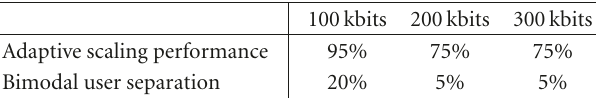
Table 5: The first row shows percentage of users who prefer the proposed content-aware scaling to all fixed scaling options. The sec- ond row shows the percentage of subjects who preferred the adap- tive scaling option with respect to subject type rather than constant scaling option with respect to subject type.